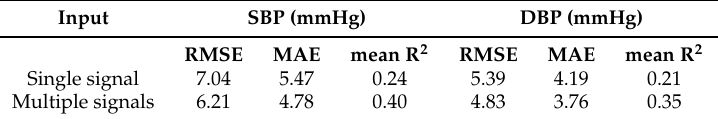
Table 4. Mean values of RMSE, MAE, and R 2 when the input was a single signal and when it was a combination of multiple signals.